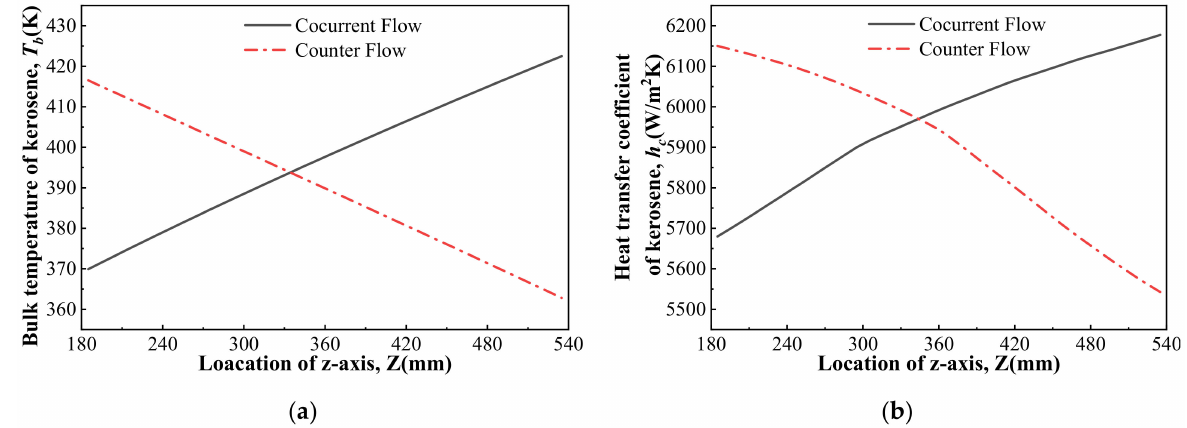
Figure 13. Variation of T b and h c along the z-axis in cocurrent and counter flow: ( a ) T b ( b ) h c .